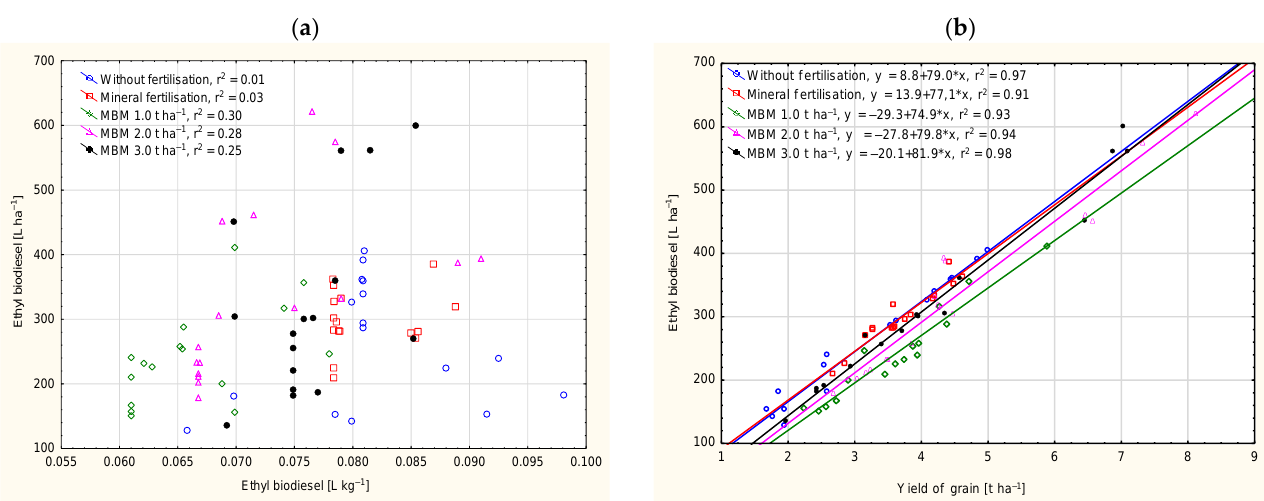
Figure 9. Dependence of ethyl biodiesel yield on volume obtained from 1.0 kg – 1 of grain ( a ) and grain harvest from 1.0 ha – 1 ( b ) (calculated at significance α = 0.05). MBM— Meat and Bone Meal. The highest volumes of ethyl biodiesel were found in grain obtained from facil- ities without fertilization (0.0819 L kg − 1 ) and those fertilized with mineral fertilizers (0.0810 L kg − 1 ) (Figure 10). This did not translate into yields of ethyl biodiesel extracted from grain per hectare of corn crop. The highest amounts of ethyl biodiesel per 1 ha were obtained after applying 2.0 and 3.0 t ha of MBM (336 and 322 L ha − 1 , respectively), which correlated with the highest yields on these